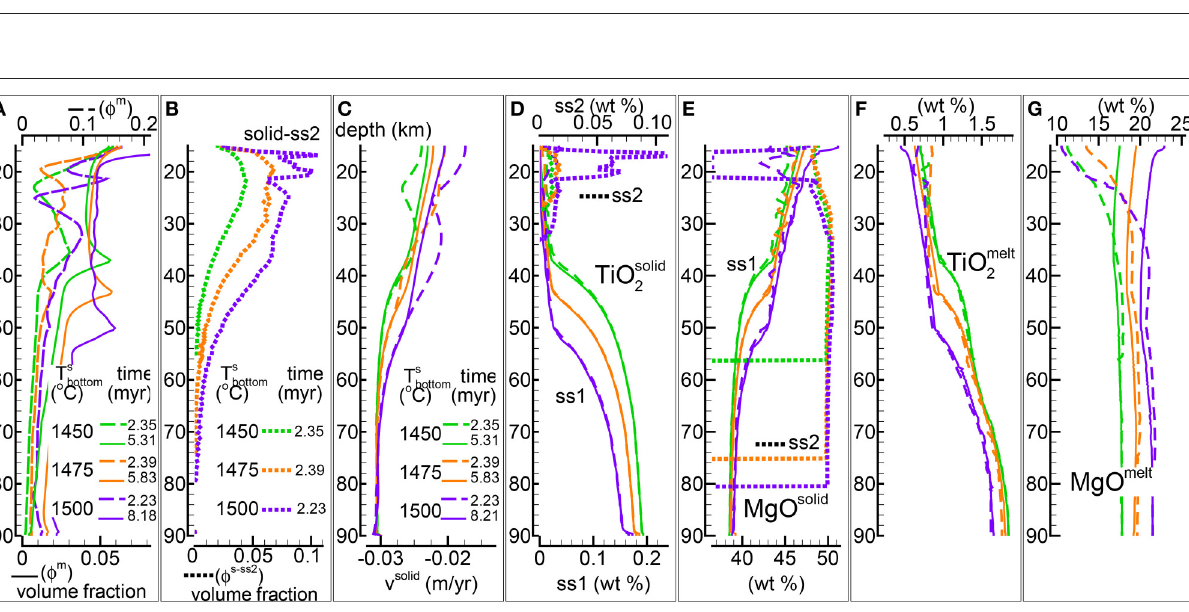
Frontiers in Earth Science |